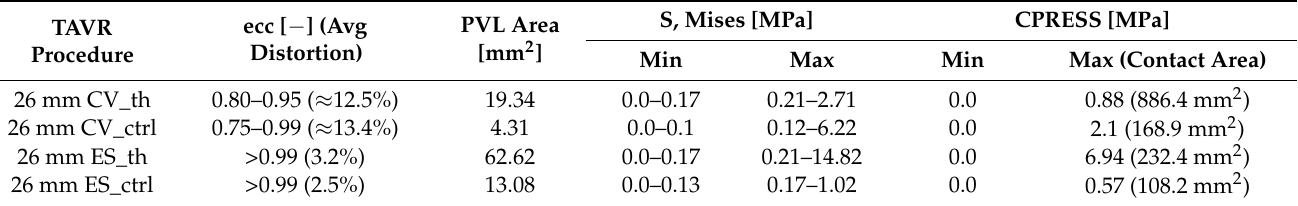
Figure 4. Postoperative medical images ( a , c , a′ , c′ ) compared to the FEA results of the TAVR simulations ( b , d , b′ , d ′, front and top view, respectively) of the CoreValve and Sapien devices. The red areas show paravalvular orifices due to the presence of residual calcifications, and the blue arrows indicate the major distortion of the frames and their incomplete and/or asymmetric expansion. Table 1. Postprocessing of FEA